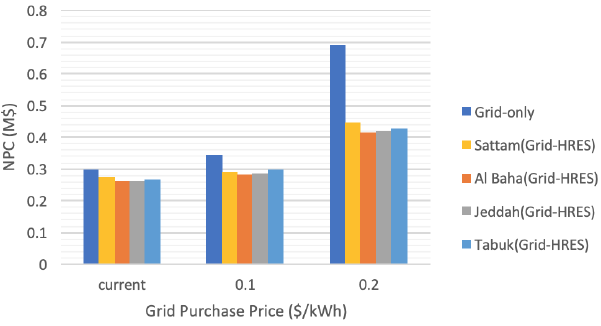
Figure 12: Comparison of tariff variation effect on total NPC.